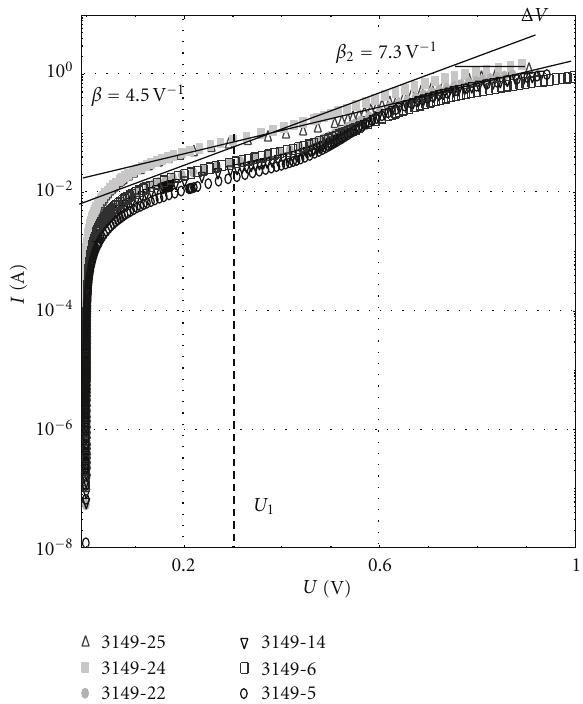
Figure 4: Dark I-V characteristics of the group of solar cells 3149 (homogeneous